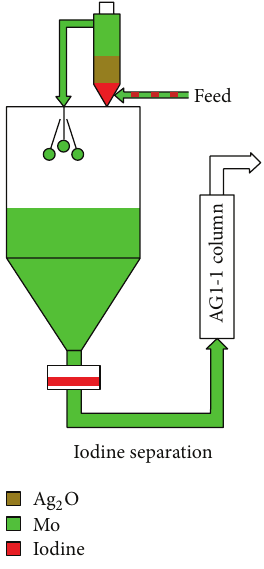
Figure 4: Separation of Iodine (taken from [23]) using a floating bed of hydrated Silver oxide and a filter, KSA/KSS